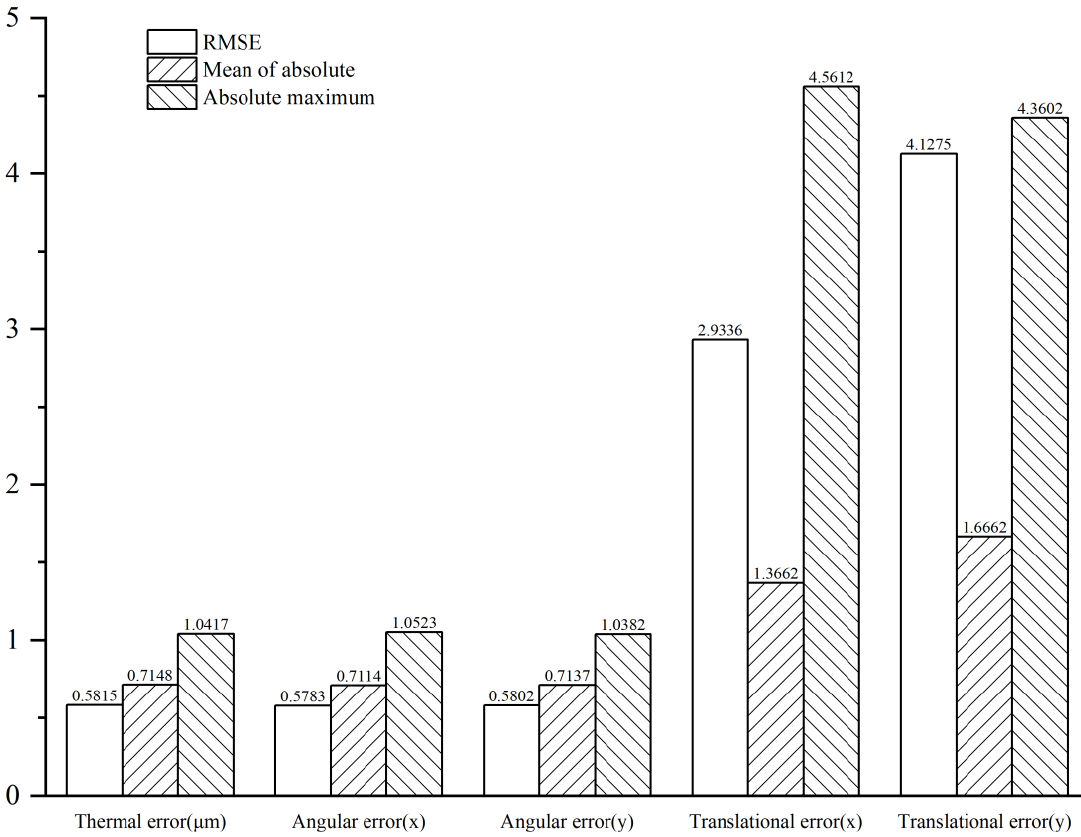
Figure 2. Fitting performance of the MRA model.